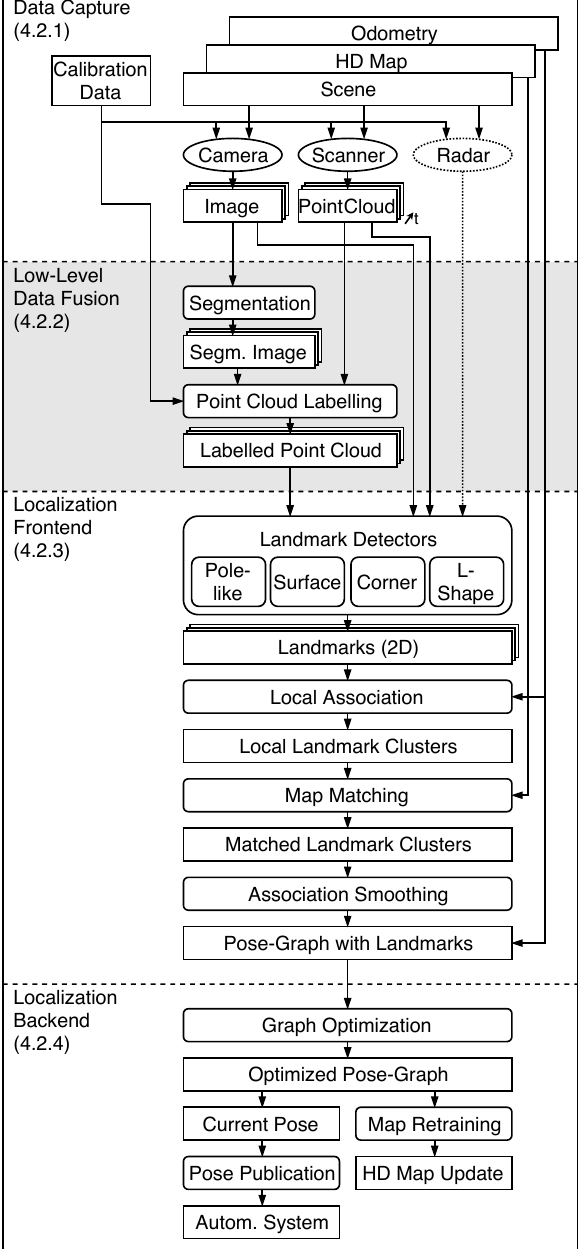
Figure 2. Abstract concept on vehicle self-localization